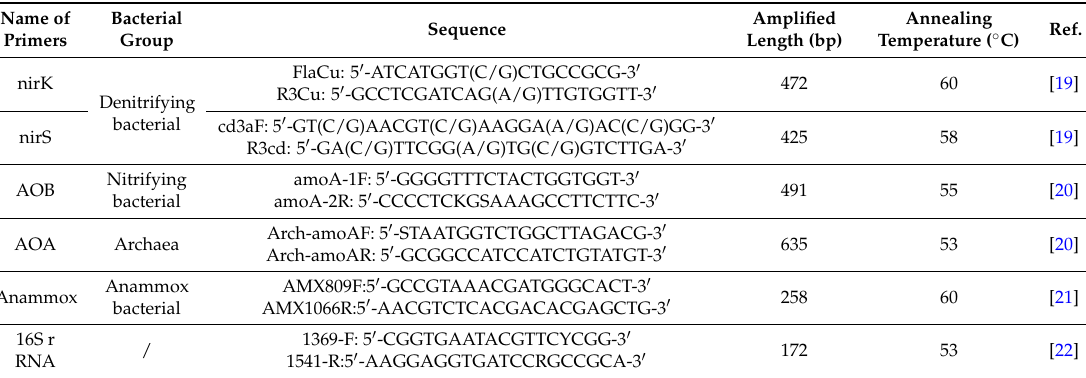
Table 2. Primer sequences and annealing